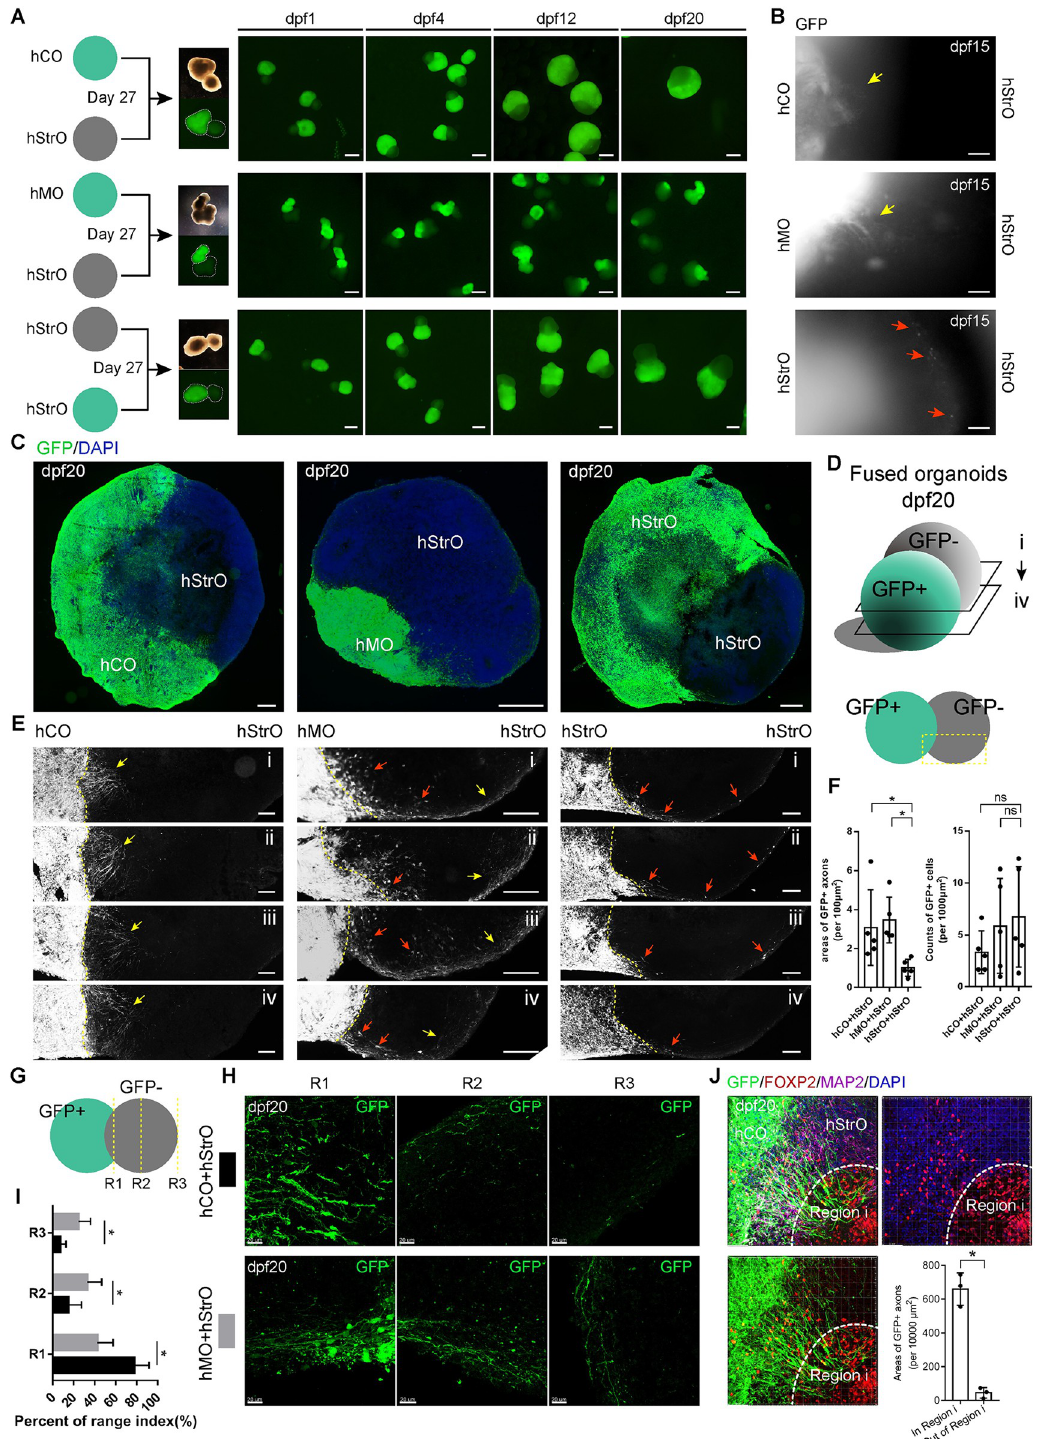
Fig 5. Fused organoids reconstructed the projection target striatum in vitro. (A) Schematic view showing the generation of fused organoids. Fluorescent images of fused organoids within dpf 20. Scale bar, 1 mm. (B) Higher magnification of fused organoids during culture. Yellow arrows showed GFP+ axons projected out from hCO and hMO; red arrows showed GFP + migration cells from hStrO. Scale bar, 100 μ m. (C) Stitching images of fused organoids at dpf 20. Scale bar, 200 μ m. (D) Schematic view of serial sections observed in fused organoids. (E) Serial sections of fused organoids revealed GFP+